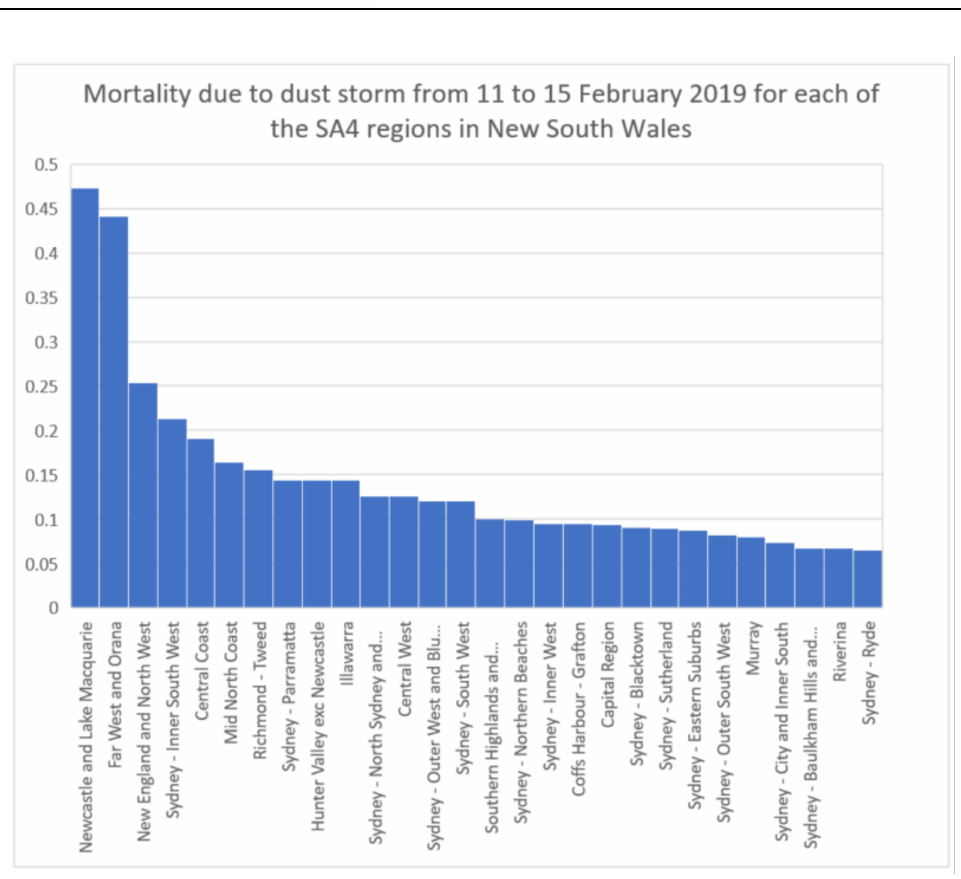
Figure 10. Estimated mortality (number of people premature death due to elevated PM 2.5 in each SA4 census district in NSW) caused by dust storm and wildfires for the period from 11 to 15 February